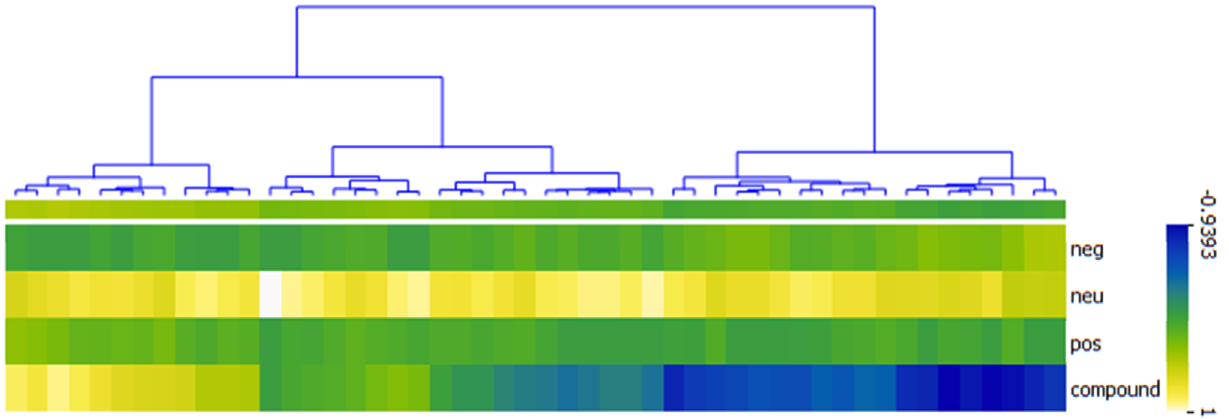
The VADER method classified the 173 unique tweets by returning the negative, neu- tral, positive, and compound scores as shown in Figure 7 using the heat map. The right- hand side (RHS) consist of 142 tweets. 73 (42.20%) tweets were negative as depicted by the blue color on the heat map; their compound sentiment scores ranged between − 0.0516 to − 0.9393 with very low positive sentiment scores, close to zero (0). For the tweets classi- fied as neutral, the positive, negative, and compound sentiment orientation scores, all re- turned zero (0), while the neutral scores were all one (1). This returned 43 (24.86%) neutral tweets. The third class in the heat map’s RHS are tweets whose compound sentiment scores are above zero (0) but below 0.5. They do not represent negative or neutral senti- ments and are also below the 0.5 thresholds to be considered as positive sentiment tweets. These classes of tweets are referred to as no-zone sentiment tweets with 26 (15.03%) tweets. Their compound sentiment scores ranged between 0.0202 and 0.4767, and their color on the heat map is not distinct. The left-hand side (LHS) of the heat map in Figure 7 has 31 instances. These are classified by VADER as positive tweets, their compound scores range between 0.5106 to 0.9508. They are represented with the visible yellow color on the heat map. The result showed that a chunk of the tweets classified as Neutral by Liu Hu are in the RHS of the VADER heat map. Figure 6. Heat map showing sentiments classification using Liu Hu method.